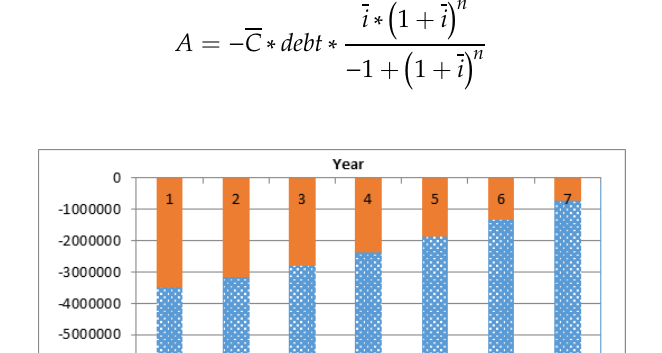
Table 2. Annual repayment.